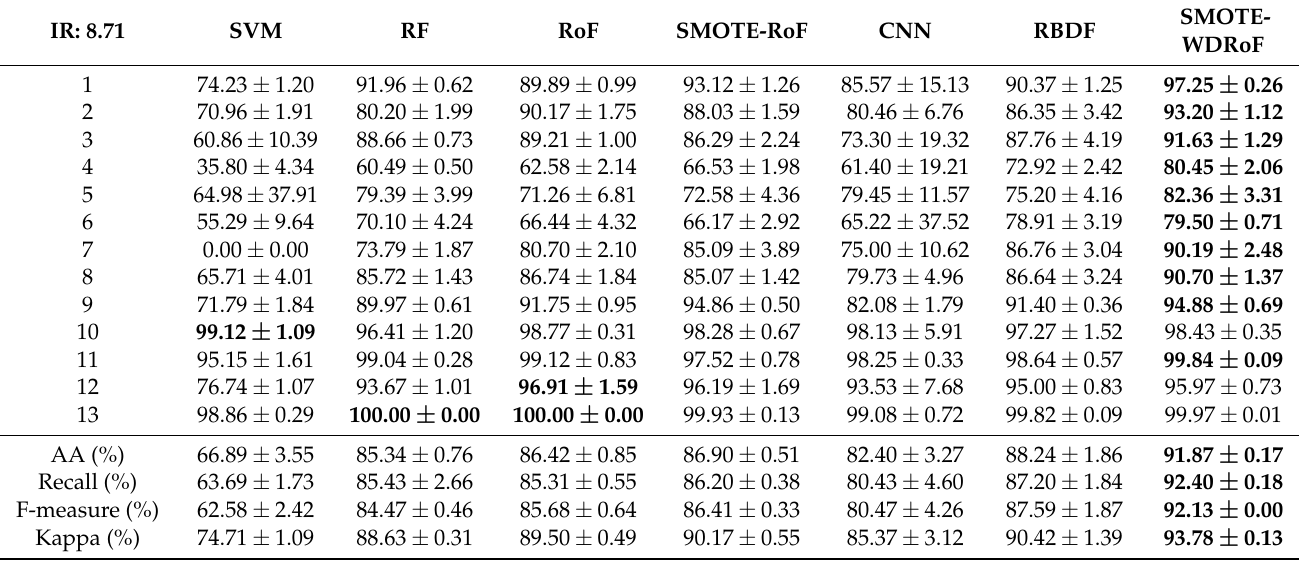
Table 3. Classification results (%) of the KSC image, respectively obtained by SVM, RF, RoF, SMOTE-RoF, CNN, RBDF and the proposed SMOTE-WDRoF in the case of the imbalance ratio of